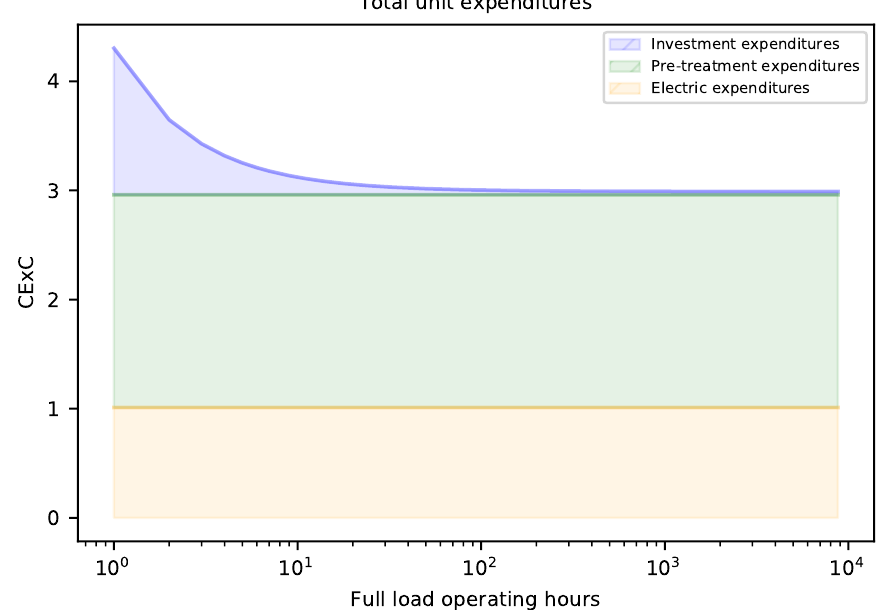
Figure 2. Total unit expenditures for investment, pretreatment and exergy consumption. (Source: own representation).